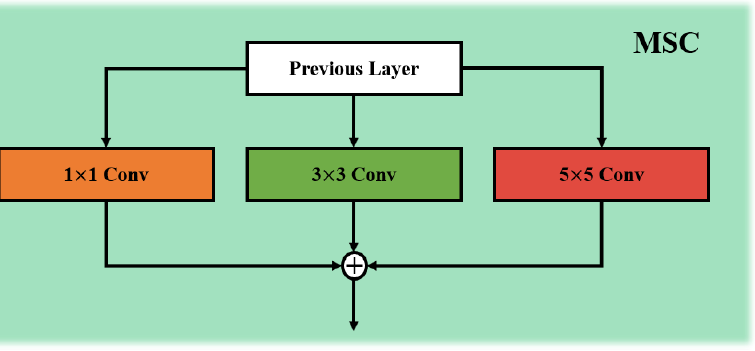
Figure 5. Multi-scale feature extraction